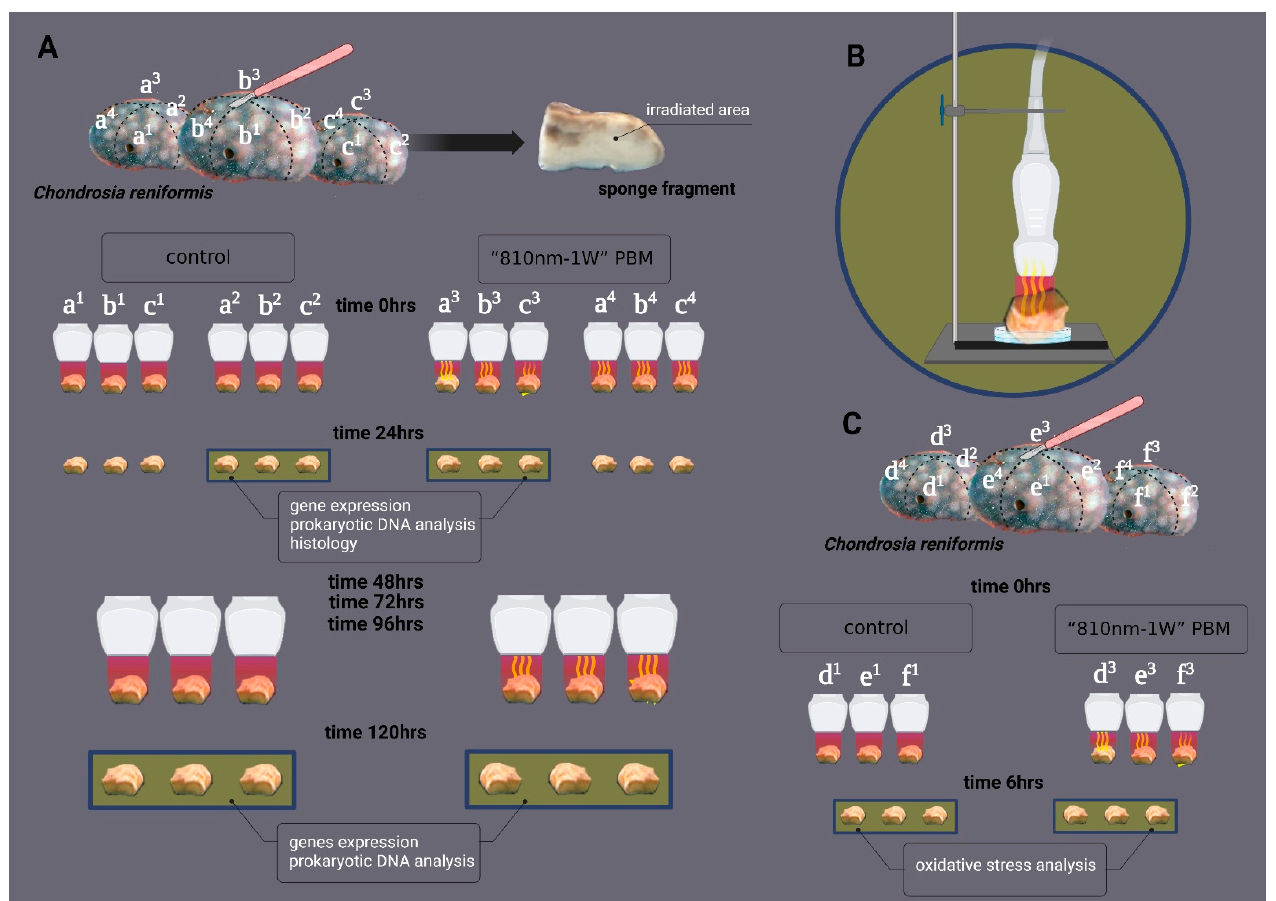
Figure 7. Summary of the experimental design used in the study. ( A ) Three Chondrosia reniformis were cut into four fragments (a1, a2, a3, and a4; b1, b2, b3, and b4; c1, c2, c3, and c4). A total of 12 fragments were obtained and were equally subdivided into two groups. ( B ) Six fragments (a1, a2; b1, b2; c1, c2) were irradiated with 810 nm-0 W, 0 J (control), and six fragments (a3, a4; b3, b4; c3, c4) were exposed to 810 nm-1 W PBM. Irradiation was performed daily for five days, and the specimens were analysed for gene expression, prokaryotic DNA analysis, and histology. ( C ) Three C. reniformis were cut into four fragments (d1, d2, d3, and d4; e1, e2, e3, and e4; f1, f2, f3, and f4). A total of 12 fragments were obtained, and six of these were equally subdivided into two groups. Three fragments (d1, d2; e1, e2; f1, f2) were irradiated with 810 nm-0 W, 0 J (control), and three fragments (d3, d4; e3, e4; f3, f4) were exposed to 810 nm-1 W PBM. Irradiation was performed on the first day (0 h), and the specimens were collected after 6 h for oxidative stress analysis. Irradiations were performed with a flat-top hand-piece fixed to a stand 0.5 cm from the sample ( B